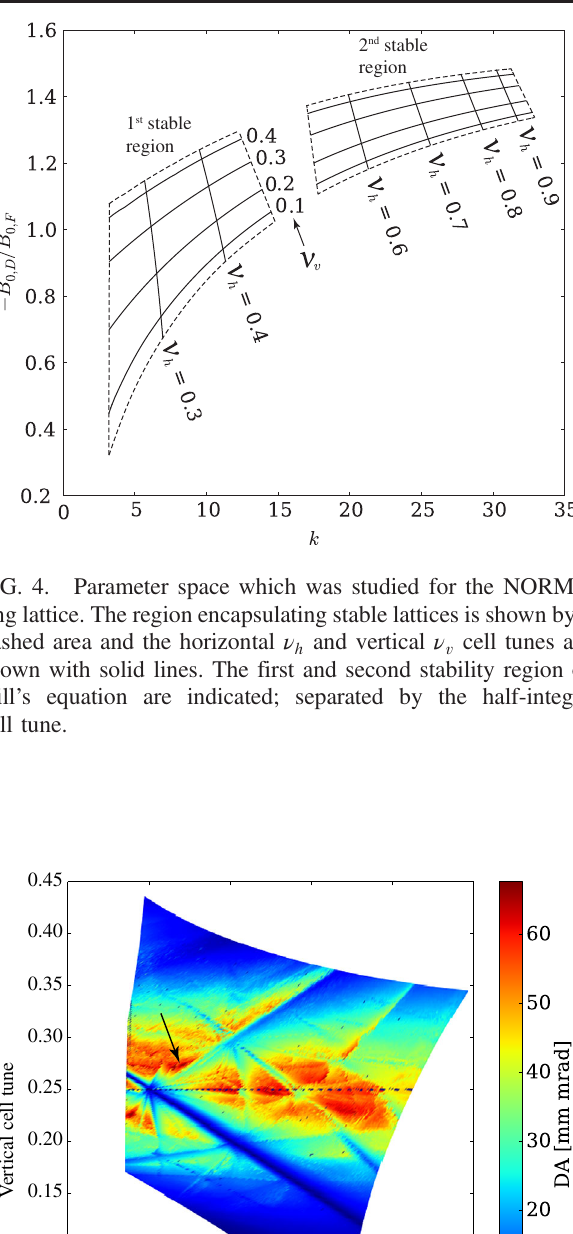
TABLE III. The main parameters of the optimized NORMA